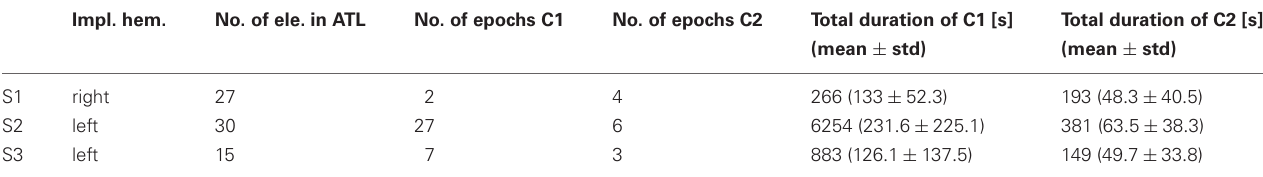
Table 2 | Electrode implantation and details of analysis. Impl.